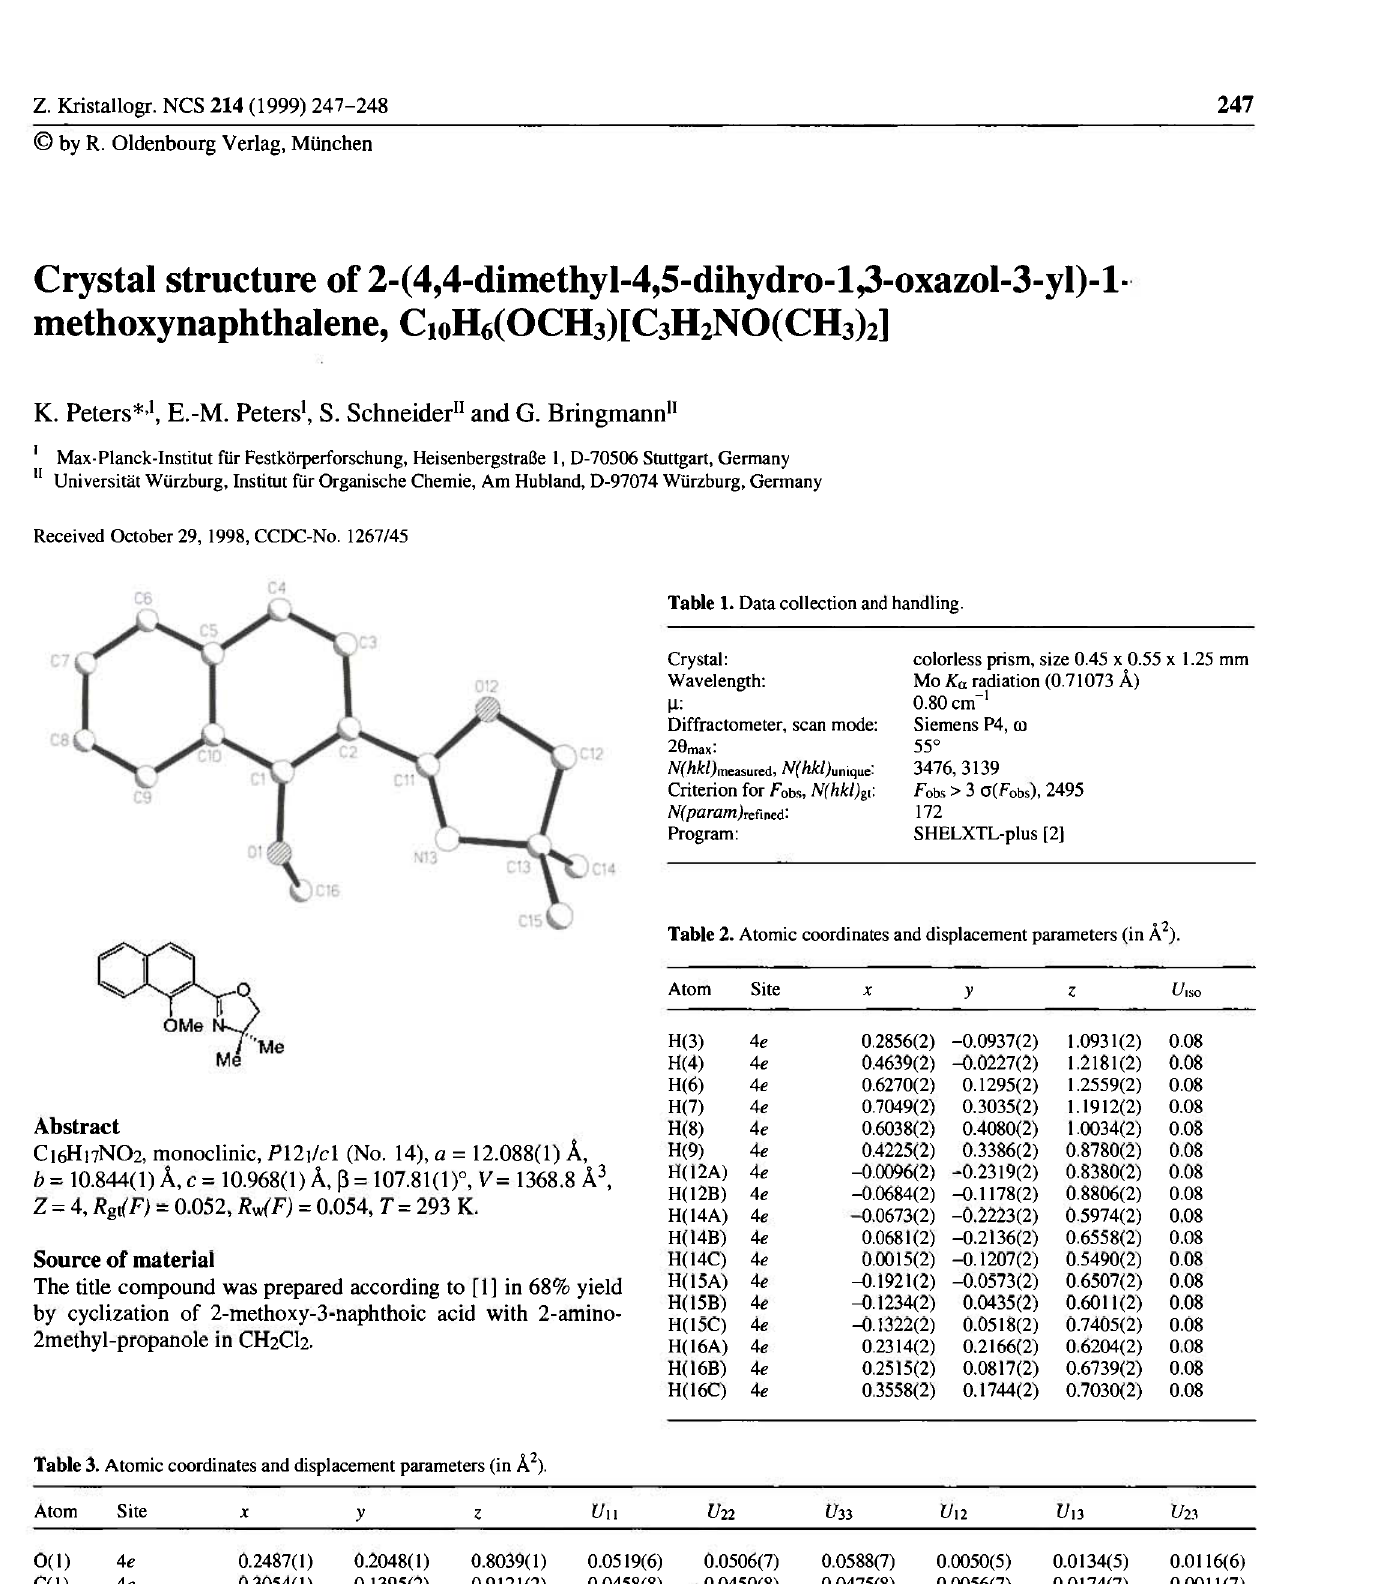
Table 3. Atomic coordinates and displacement parameters (in Ä 2 ).